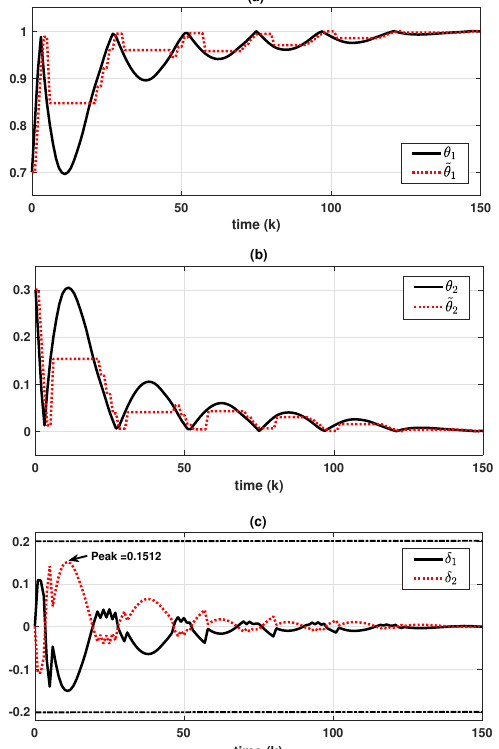
Figure 5. FBF module: ( a , b ) fuzzy-basis functions θ and ˜ θ , and ( c ) fuzzy basis function error δ